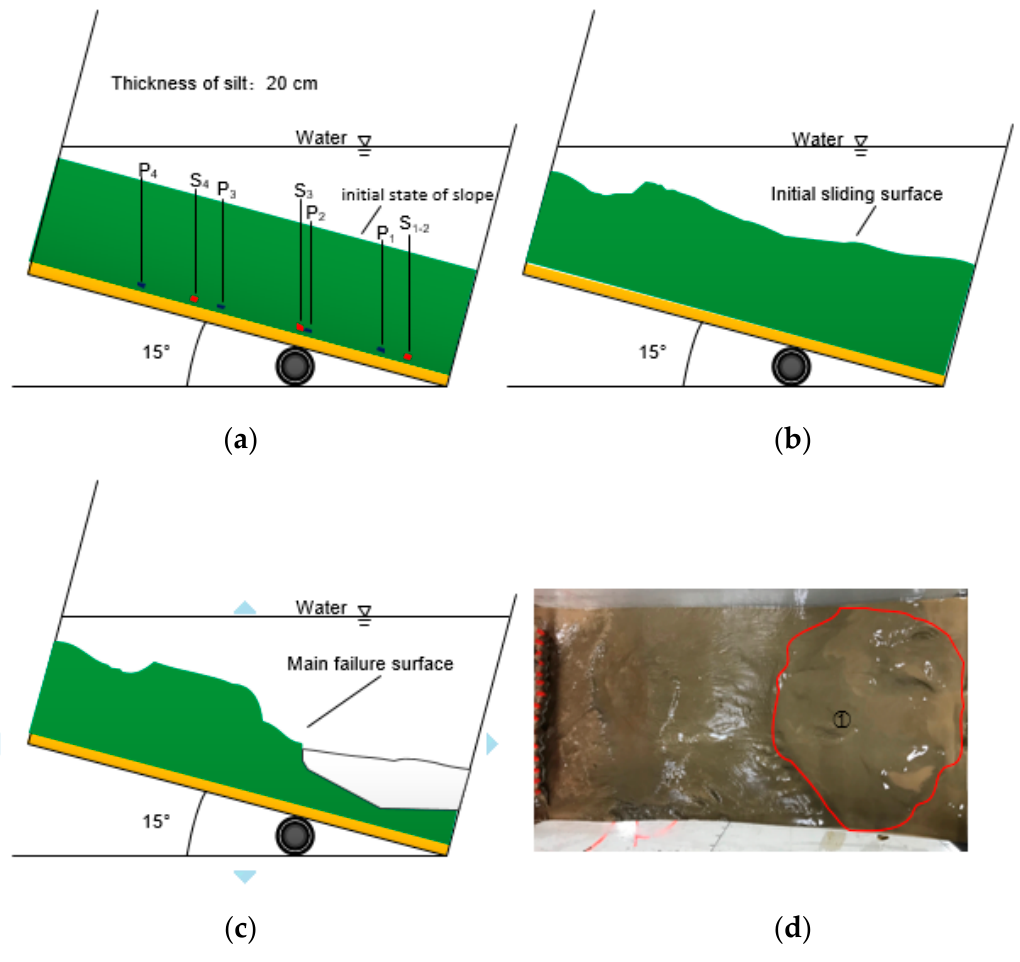
Figure 9. Profile and plan views of the slope after failure in Model 20-15. ( a ) Before Angle adjustment; ( b ) After the Angle adjustment; ( c ) After the destruction; ( d ) top view of end of experiment.